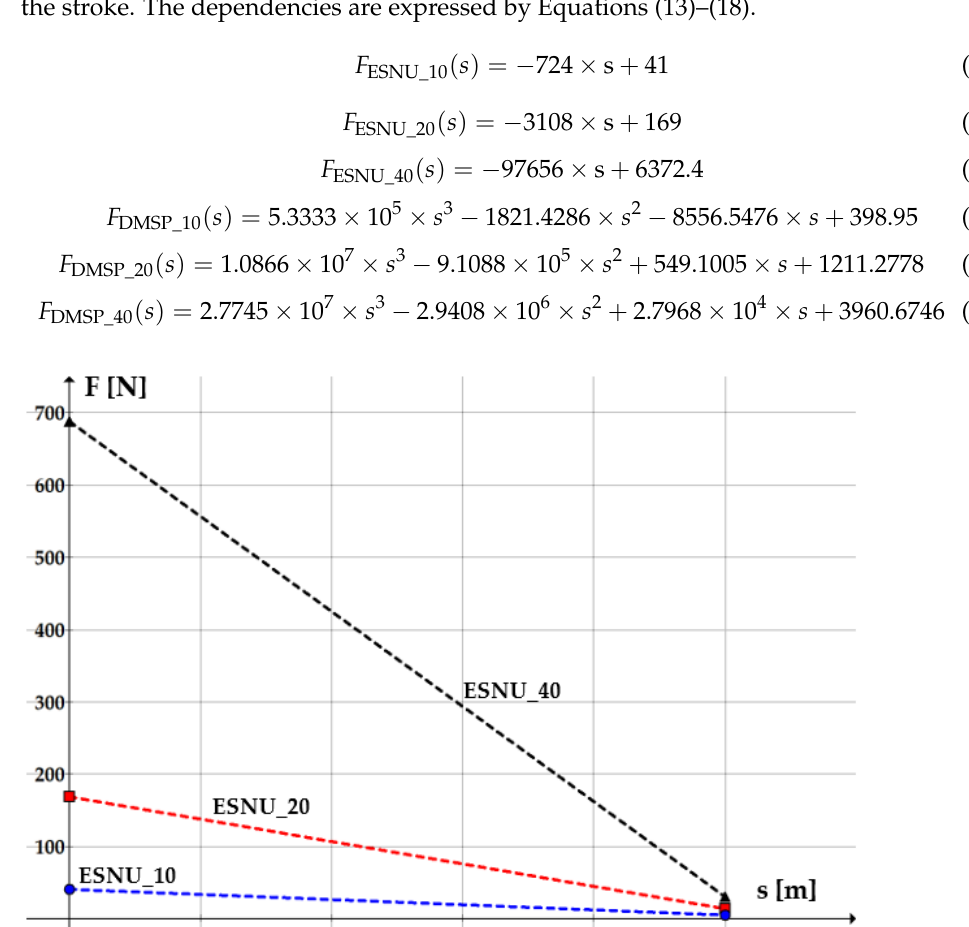
Table 4. Forces developed by the ESNU pneumatic cylinders.